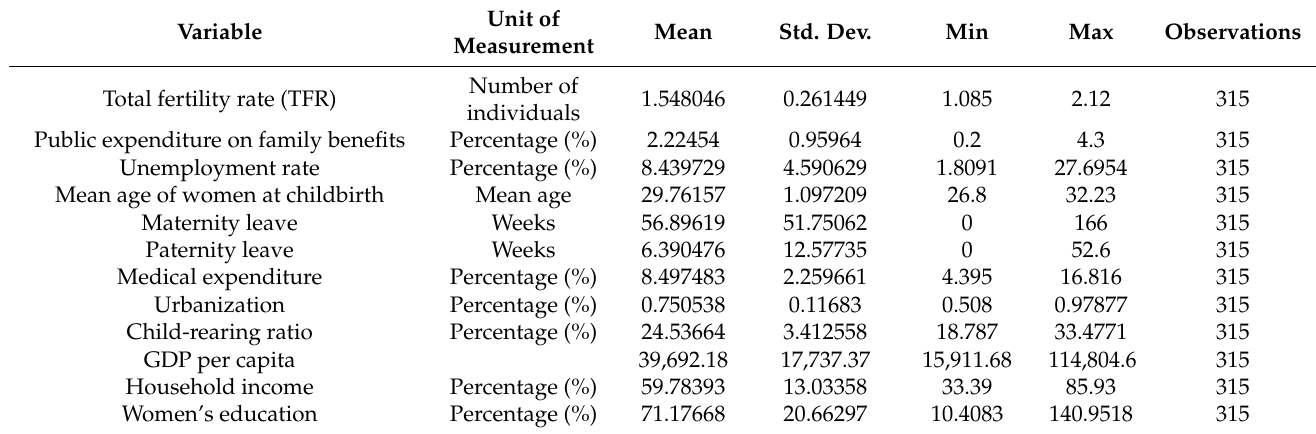
Table 3. Descriptive statistics of variables.